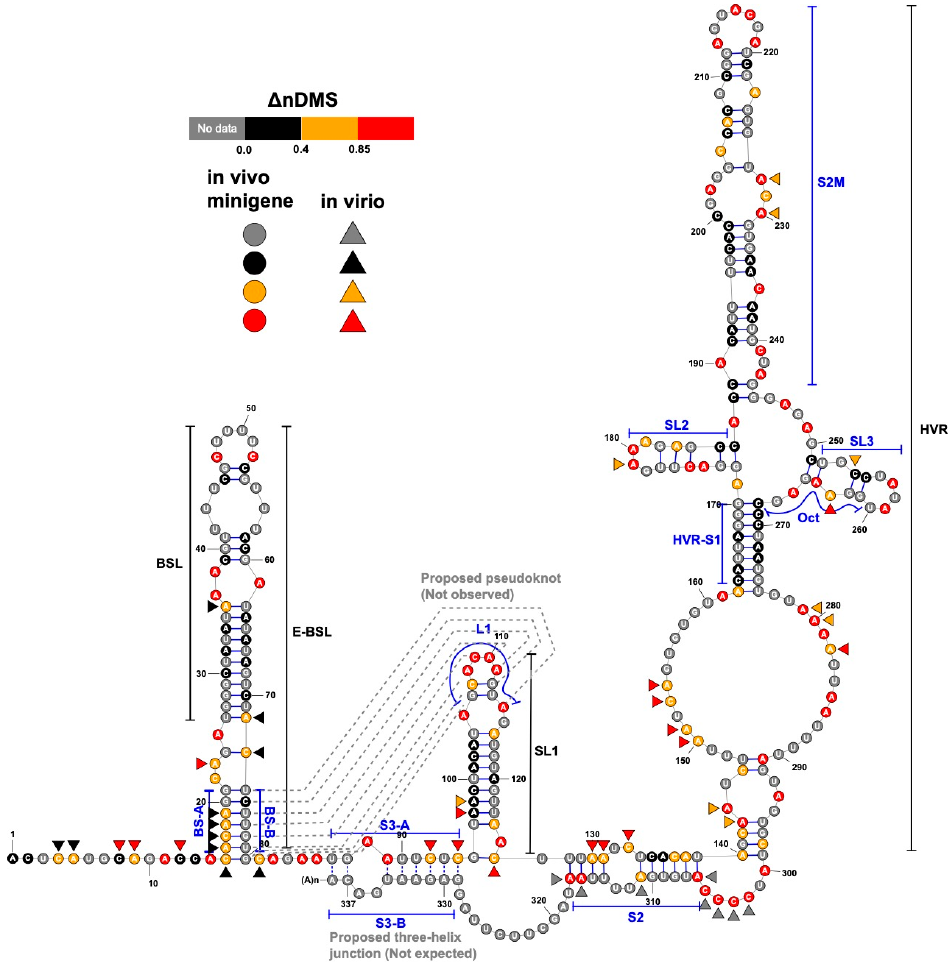
Figure 4. A consensus structure derived from the in-virion and in vivo minigene DMS-MaPseqs. The Δ nDMS reactivity for each nucleotide from the in vivo minigene DMS-MaPseq is colored according to the legend on the RNA backbone, with the in-virion DMS activity drawn aside if it belongs to a different reactivity group. The occurrences of the base pairing for BS-B–L1 and S3-A–S3-B (dotted lines) are not supported in this study.